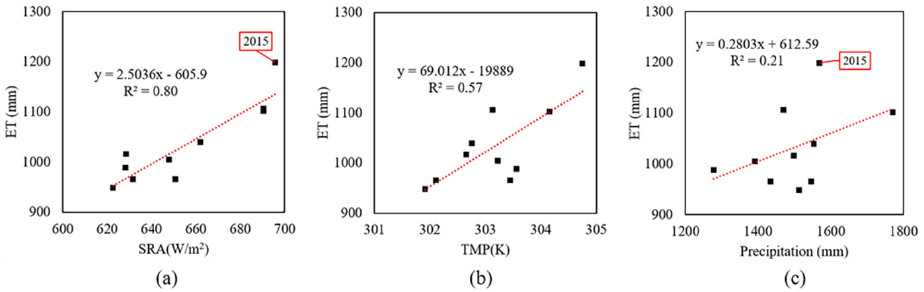
Figure 10. Correlation analysis between meteorological factors and annual ET. ( a ) SRA; ( b ) Precipi- tation; ( c ) TMP.